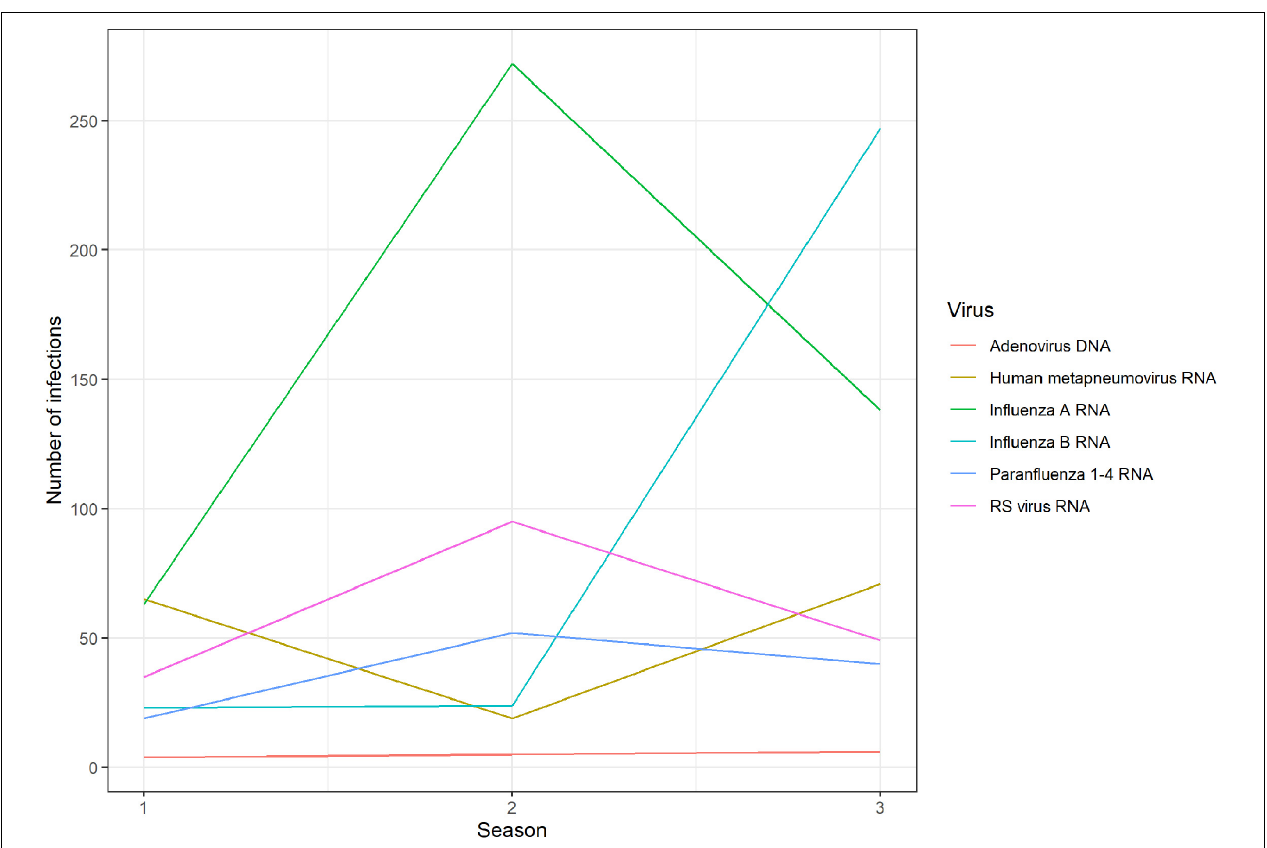
FIGURE 2 | Number of admissions due to the different viral agents during the three winter seasons 2015–2018.